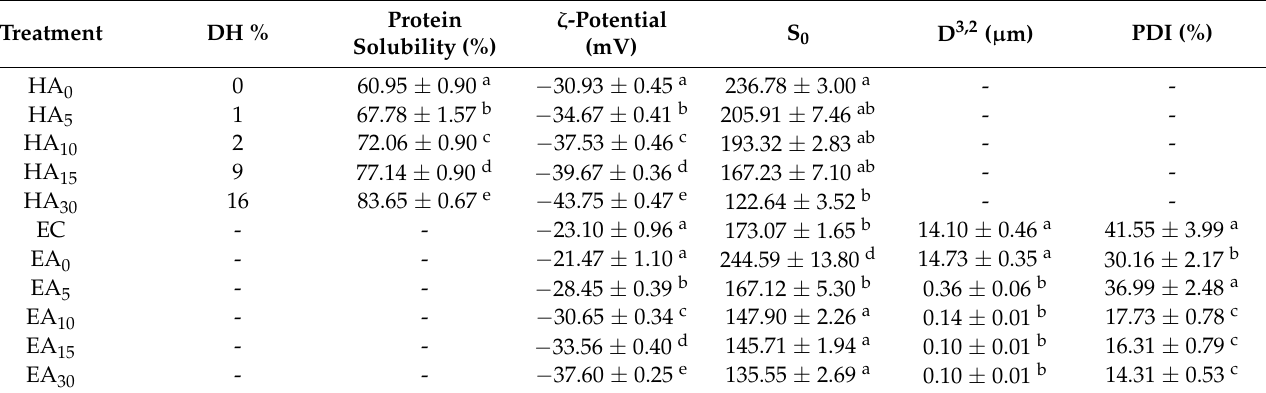
Table 2. Physicochemical properties (Degree of hydrolysis ~ DH %, Protein Solubility (%), ζ -potential, Hydrophobicity index ~ S 0 , Droplet size ~ D 3,2 , and Polydispersity index ~ PDI) of faba bean hydrolysates (FBH) and faba bean emulsions (FBE)